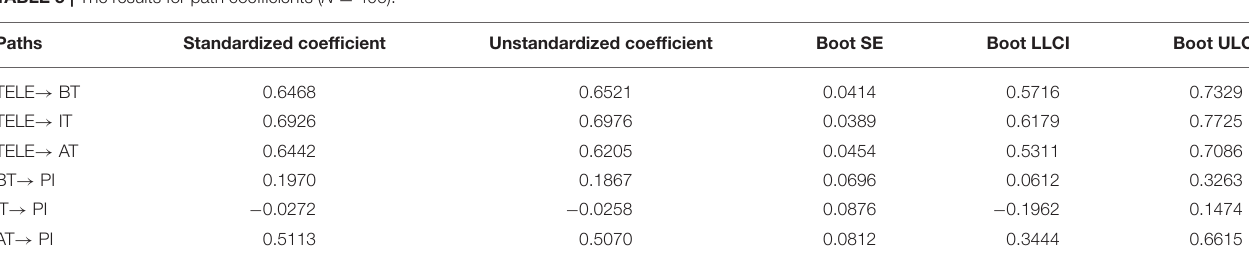
TABLE 5 | The results for path coefficients ( N =